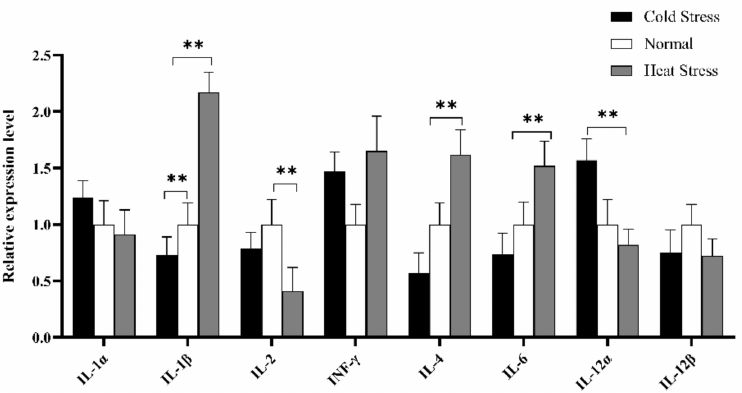
Figure 9. Expression analysis of immune cytokines profiles in splenic tissue of di ff erent groups (HS, NS, CS) broiler by RT-qPCR methods. The x -axis represents di ff erent cytokines, and the y -axis represents the relative expression level of cytokines. Data are presented as mean ± standard error. * on the top of lines or bars indicated a significant di ff erence (** p < 0.05) between heat stressed and normal